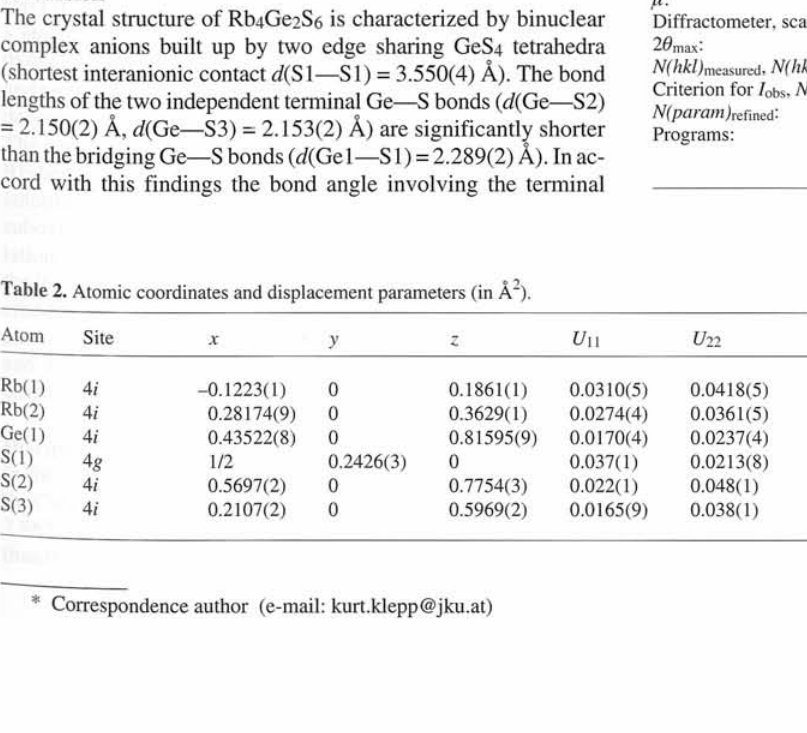
Table 2. Atomic coordinates and displacement parameters (in